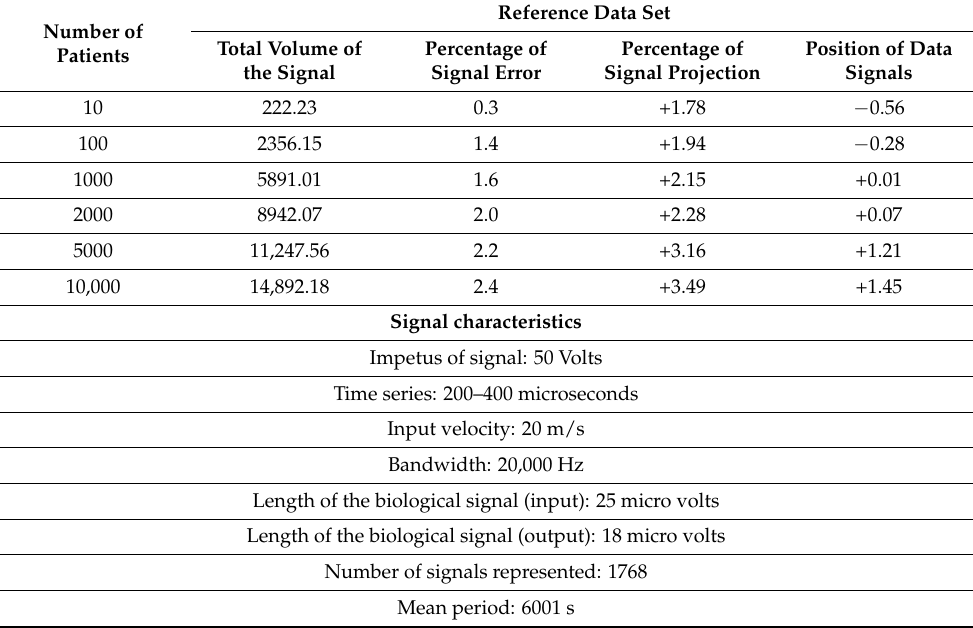
Table 1. Data set